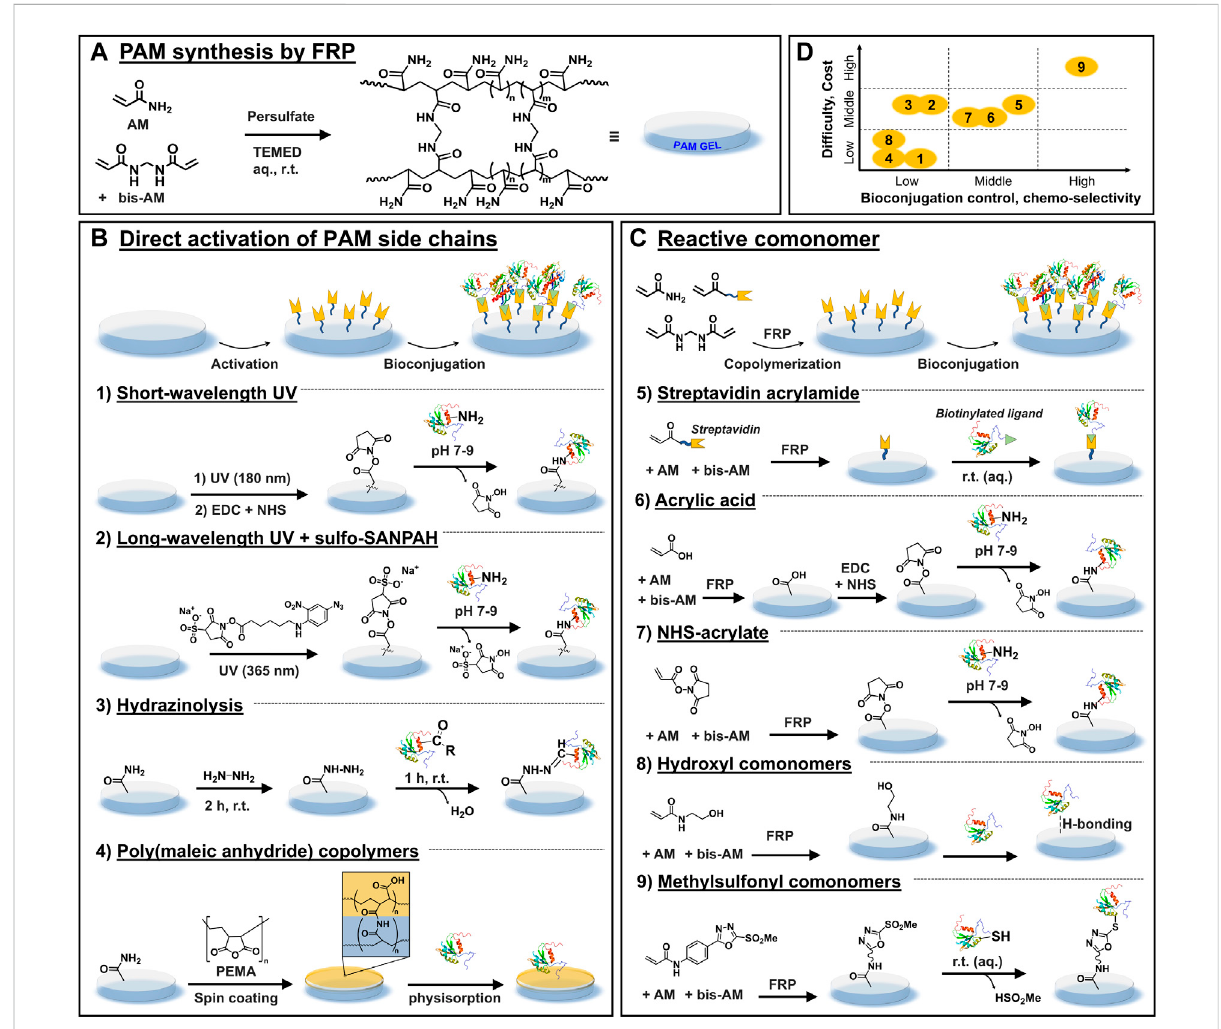
FIGURE 1 Most used chemical strategies for PAM gels biofunctionalization. (A) General scheme depicting the synthesis of PAM gels via FRP. (B) Chemical strategies based on the direct activation of the side chains of PAM after FRP, which is followed by ligand bioconjugation. (C) Chemical strategies whereby reactive comonomers are incorporated during FRP, followed by a bioconjugation step. (D) Overall qualitative comparison of the different chemical strategies in view of their experimental dif fi culty and cost vs. control of bioconjugation process and